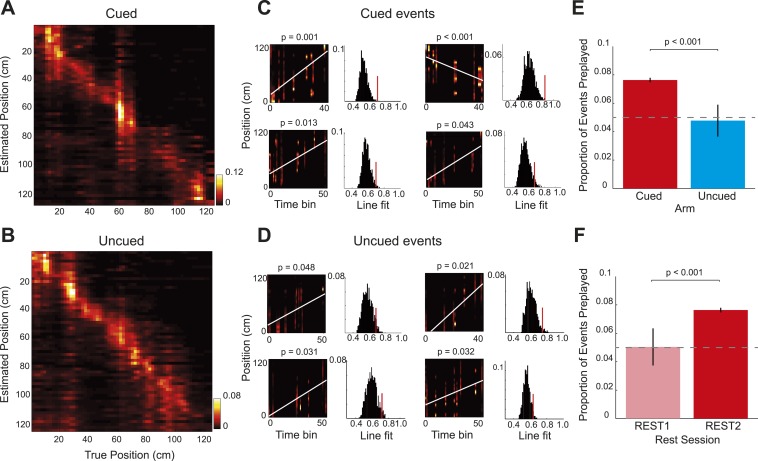
Bayesian reconstruction confirms preferential cued arm preplay.(A–B) Confusion matrices based on RUN2 data showing decoding accuracy for the cued (A) and uncued arms (B). Columns show the mean posterior probability distribution across the arm ordered by the true position of the rat (2 cm bins, data for R504). Decoding errors appear as power away from the identity diagonal—here both arms yield accurate estimates of the animal's position at all points on the track. (C–D) Representative preplay events for the cued (C) and uncued (D) arms showing, (left) the straight line trajectory that best fits the decoded event (x-axis indicates time bin (5 ms) within the event, y-axis position on arm, title indicates probability of obtaining a better trajectory by chance) and, (right) the null distribution of trajectory fits obtained by shuffling the cell identities for each event (x-axis, quality of trajectory fit, y-axis, proportion of shuffled events). (E) Proportion of spiking events categorised as preplay events for the cued and uncued arms in REST2. Bars show mean for all data with SEM. (F) Same as E but comparing preplay in REST1 and REST2 for the cued arm.